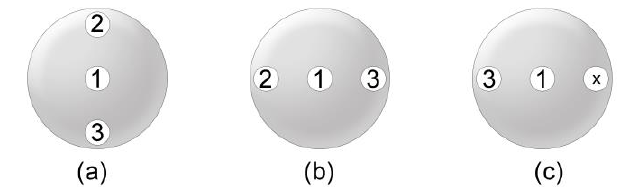
Fig. 5 - Different positioning of the detectors inside the experimental channels of SUR-100.